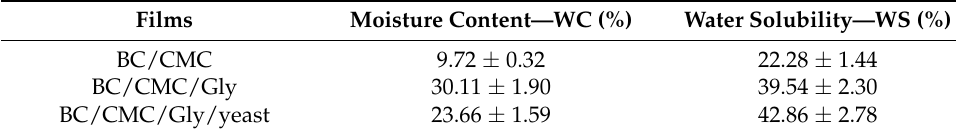
Table 1. Water solubility and moisture content of different composite films.